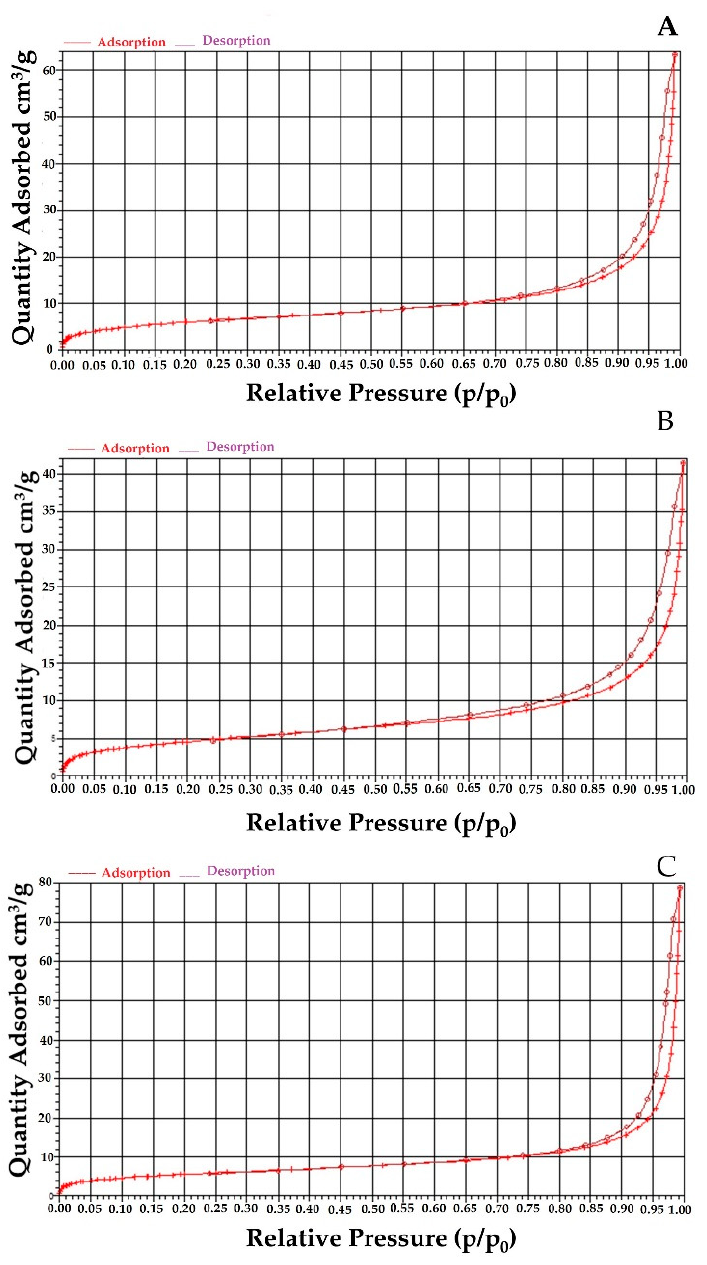
Figure 4. N 2 absorption-desorption isotherm for ( A ) bare MNPs, ( B ) PEG-coated MNPs and ( C ) quercetin-loaded PEG_MNPs. The observed decrease in the saturation magnetization could be explained either by the use of PEG for the surface modification process [43 ] that causes the softening of the magnetization or by the difference in particle size [45]. In addition, the saturation magnet- ization of PEG-coated MNPs at the maximum field of 5 kOe is 74.75 emu g − 1 , somewhat lower than bare MNPs (Figure 5B). However, the magnetization measurement of synthe- sized MNPs confirmed their superparamagnetic properties, thus confirming their further application in release studies under applied magnetic fields.